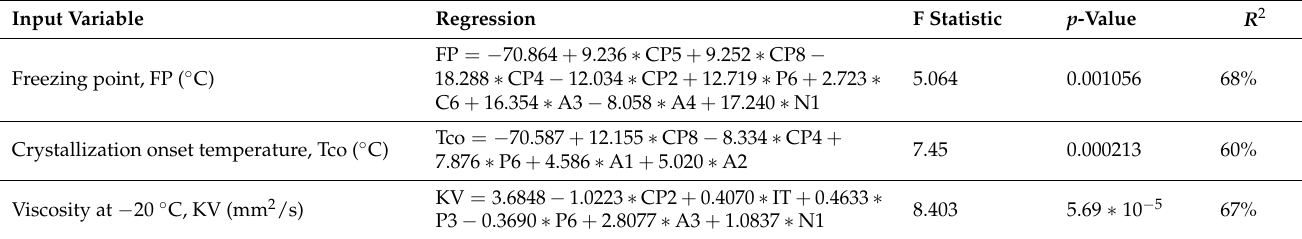
Table 6. Linear regression models for the low-temperature fluidity properties as a function of the weight fraction of the main individual components and hydrocarbon